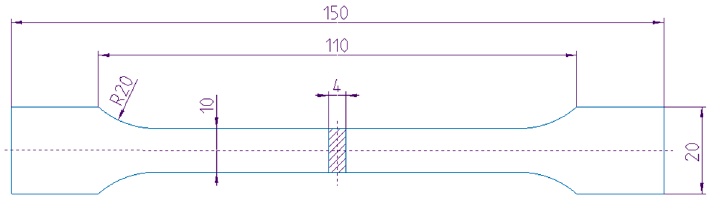
Figure 1. Possible orientations of a 1A sample in Cartesian coordinates (colored arrows).